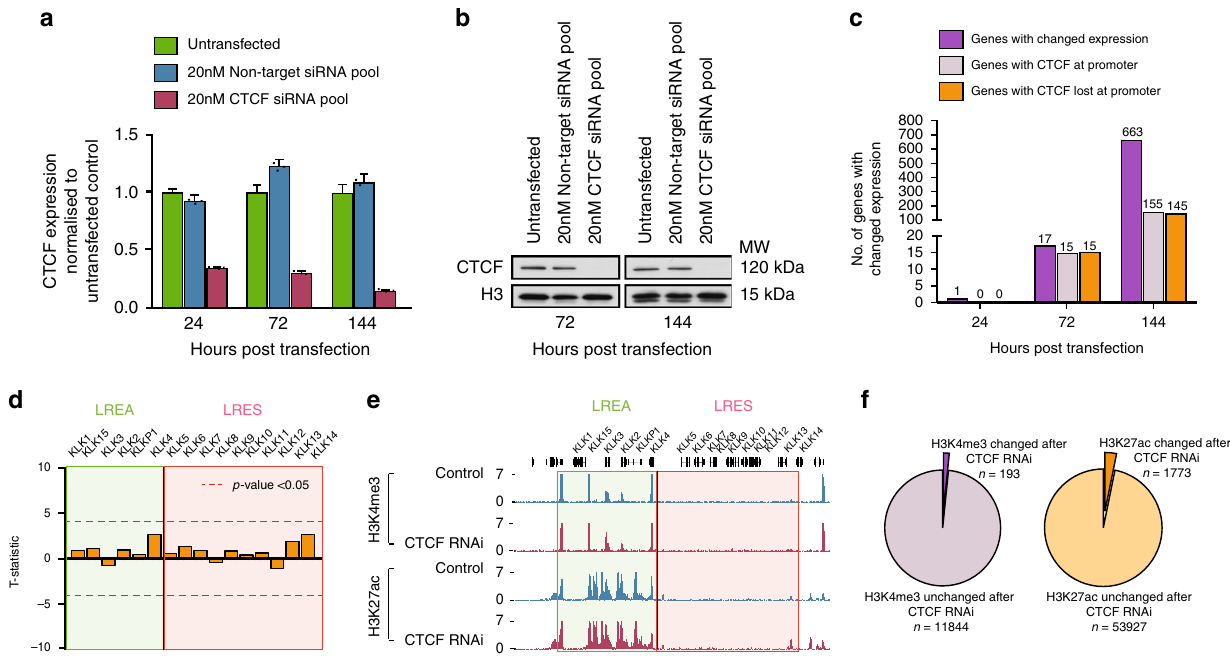
Fig. 3 CTCF RNAi leads to modest changes to gene expression and chromatin. a qPCR measuring relative levels of CTCF mRNA for untransfected, control siRNA and CTCF siRNA conditions at 24, 72 and 144 h following transfection of LNCaP cells with 20 nM control and CTCF siRNA. Error bars represent SE. Data for technical replicates n = 3 are overlaid as a dot blot. b Western blots for CTCF following 72 and 144 h of CTCF RNAi show >90% reduction of CTCF protein. Source data are provided as a Source Data fi le. c Bar graph shows total number of genes with changed expression following 24, 72 and 144 h of CTCF RNAi (dark purple). Light purple bars indicate the number of total genes with changed expression that have CTCF binding at their promoter. Orange bars show the number of this subset that loses CTCF binding following CTCF RNAi. d T -statistics show no signi fi cant difference ( p -value < 0.05, indicated by dashed line) in KLK locus gene expression between control and CTCF RNAi samples (144 h post transfection) processed on an Affymetrix Gene Chip 2.0 expression array. n = 2 biologically independent experiments. e ChIP-seq for H3K4me3 and H3K27ac following 144 h of CTCF RNAi revealed no change to binding strength at KLK region. f Venn diagrams displaying proportion of H3K4me3 and H3K27ac modi fi cations that undergo signi fi cant change in binding strength following 144 h of CTCF